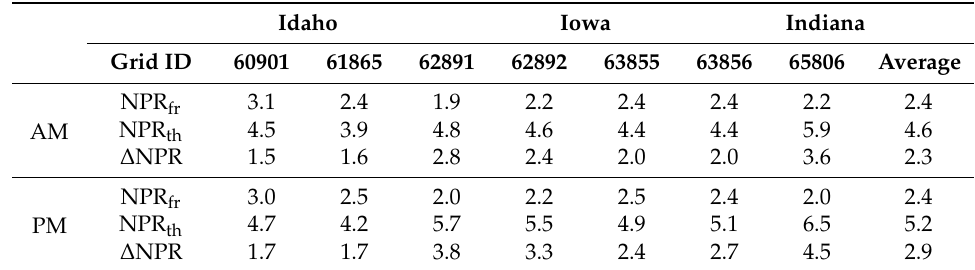
Table 3. Freeze (NPR fr ) and thaw (NPR th ) references for SMAP grids that contain CVS stations, in which ∆ NPR is computed from NPR th —NPR fr